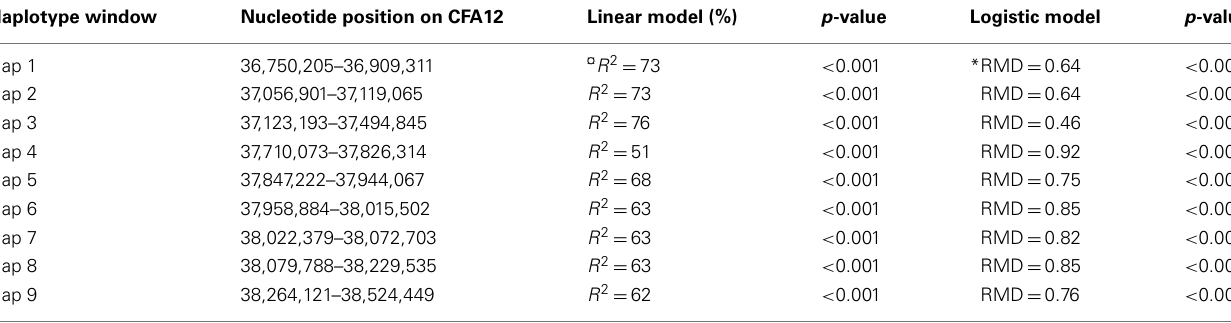
Table 4 | Haplotype substitution effects for disc calcification scored as binary cases/control disc scores. Haplotype